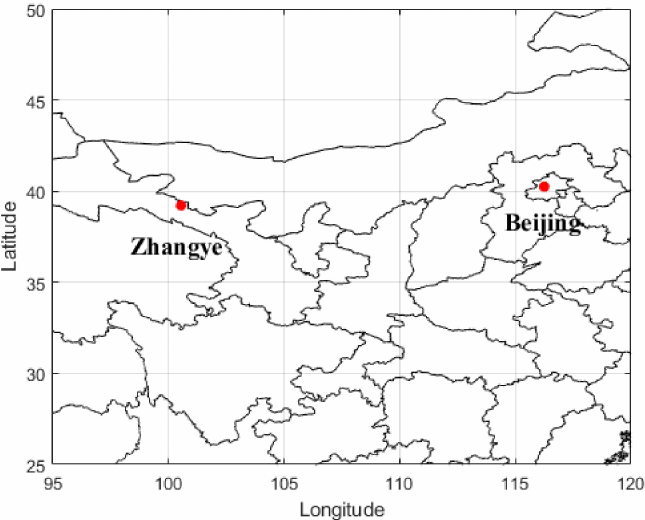
Figure 1. The locations of Beijing (40.25 ◦ N, 116.25 ◦ E) and Zhangye (39.21 ◦ N, 100.54 ◦ E).